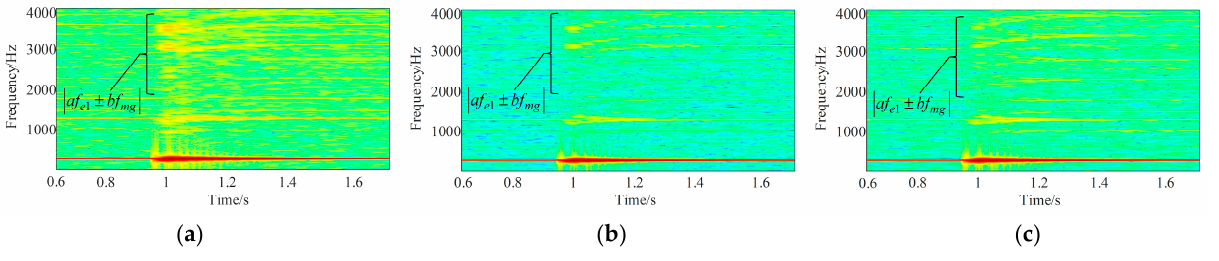
Figure 20. Time-frequency domain of the stator current of motor 1 with different values of motor shaft damping: ( a ) case 5; ( b ) case 3; ( b ) case 4. shaft damping: ( a ) case 5; ( b ) case 3; ( b ) case